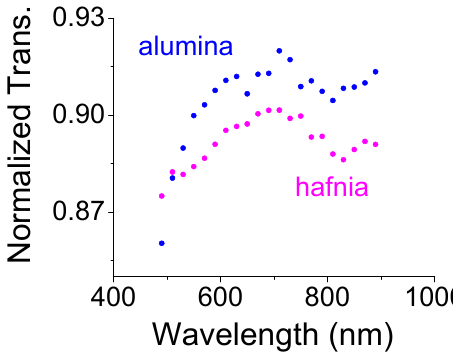
Figure 10. Transmission through 10-nm thick oxide on graphene when transferred to a glass slide. The data were normalized by the transmission of only graphene film on a glass slide.